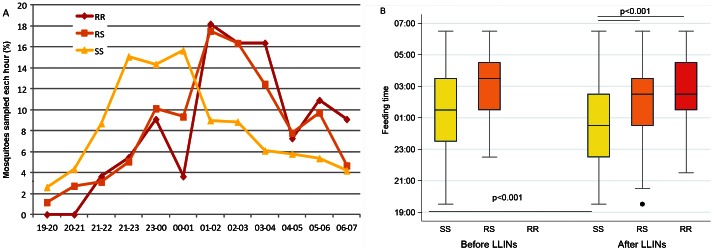
An. gambiae feeding time measured in 1494 An. gambiae s.l. mosquitoes sampled from 2006 to 2011, according to their kdr genotype (SS: wilde type, yellow lines and boxes, RS: L1014 F heterozygote, orange lines and boxes, RR: L1014F homozygote, red lines and box).Panel A represents hourly aggressiveness in specimens sampled each hour after the implementation of LLINs as a percentage of the number of specimen sampled during the night. Panel B boxes are 25th to 75th percentiles with median hour, lines are 1.5 interquartile and dots outside values, for specimens sampled from Jan 2006 to Jul 2008 (Before LLINs) and between August 2009 and Dec 2011 (After LLINs). Changes in median hour of aggressiveness observed in the SS specimen group after the implementation of LLINs (Mann-Whitney test p<0.0001) but not in RS specimens. Earlier aggressiveness detected in SS group in comparison to RS and RR after LLINs (Kurskal-Wallis test p<0.0001).